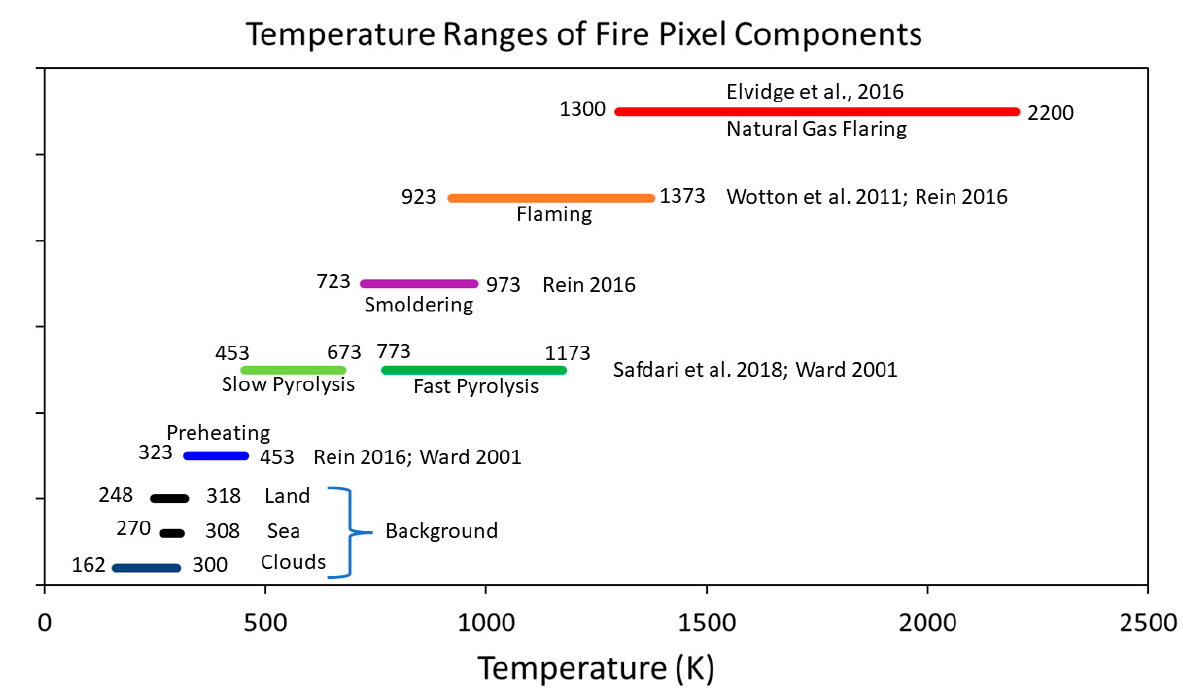
Figure 4. Temperature ranges of fire pixel components.